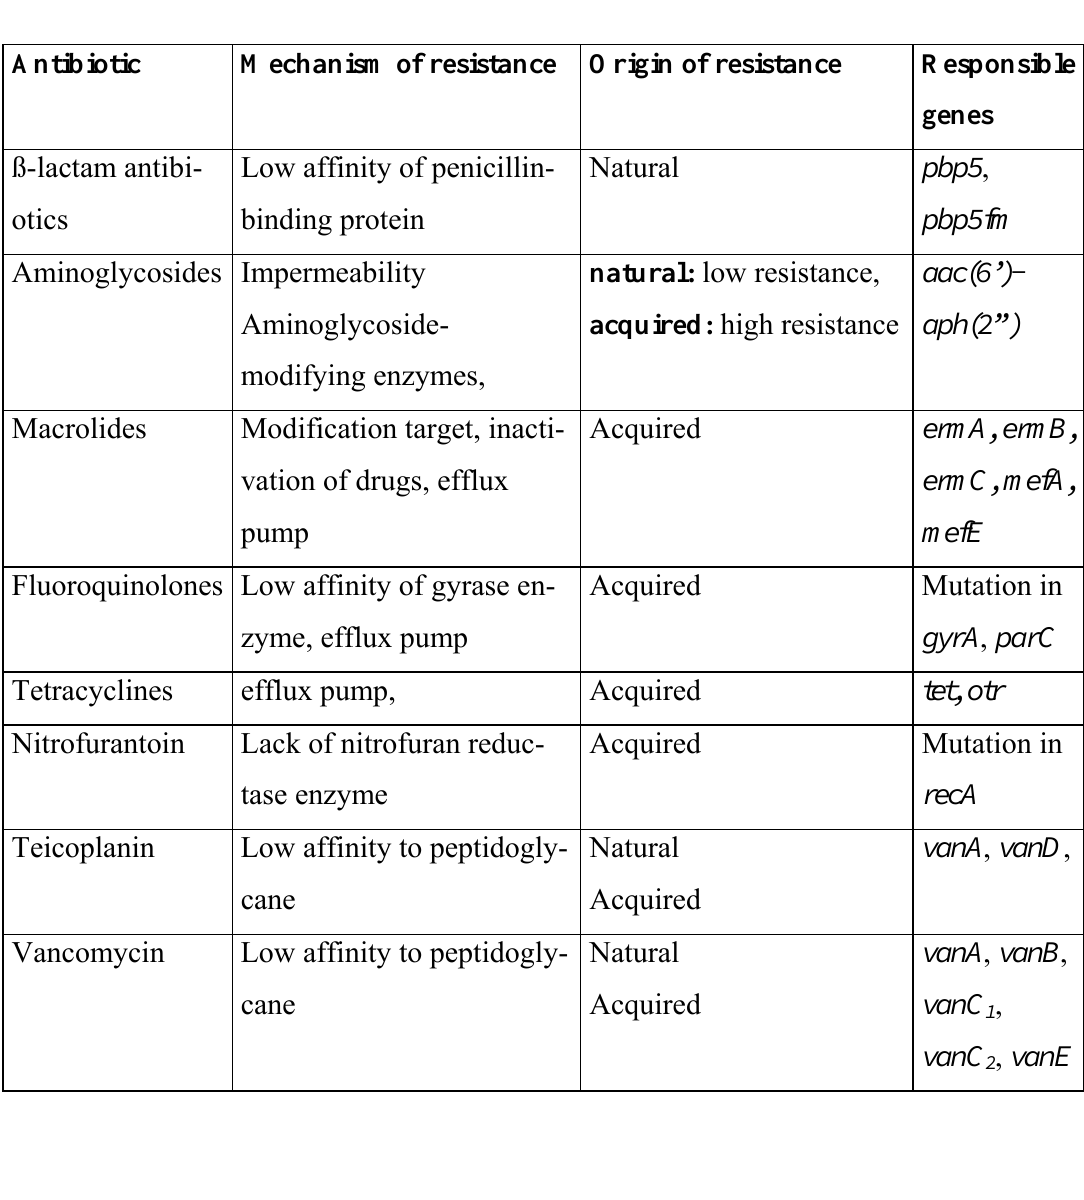
Table 2. Summary of antibiotic resistance in